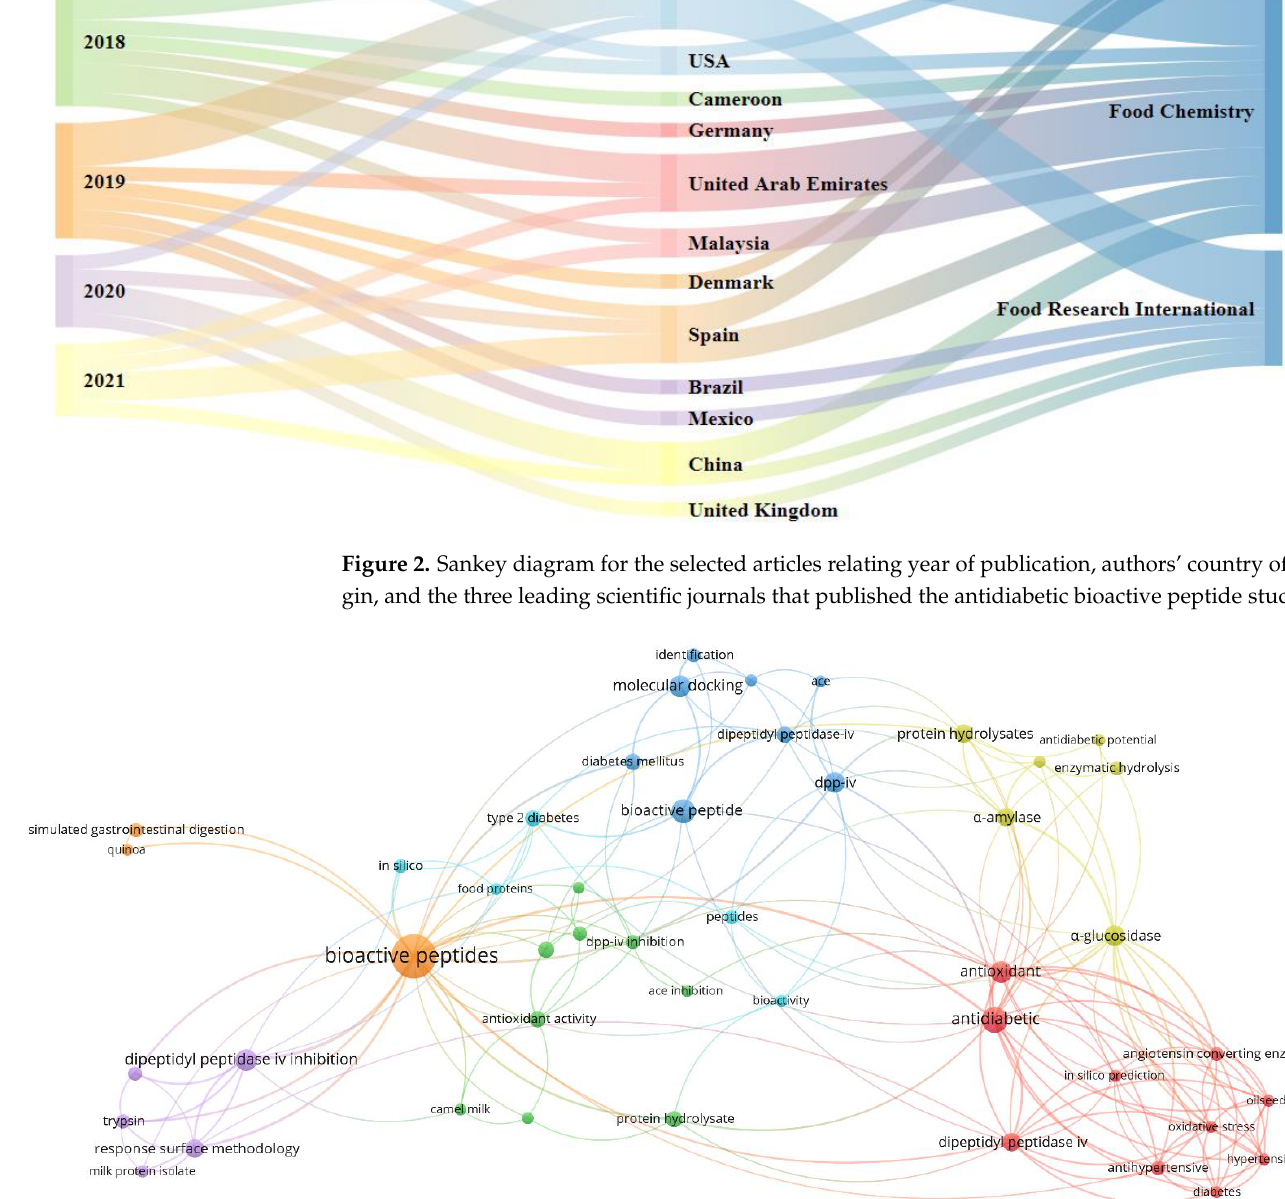
Figure 3. Network visualization map of the articles’ keywords that appeared at least twice. Node size is proportional to the number of occurrences (VOSviewer). size is proportional to the number of occurrences